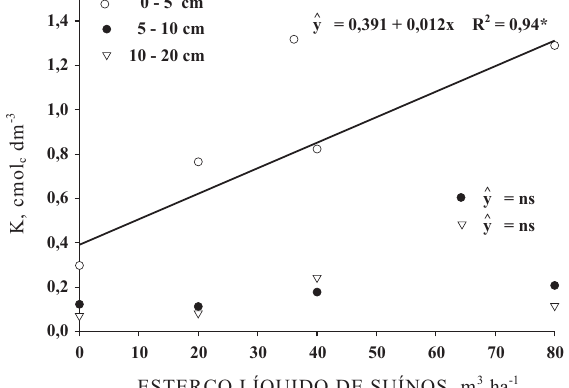
Figura 4. Teores de potássio (K), em função de doses crescentes de ELS e da profundidade de amostragem do